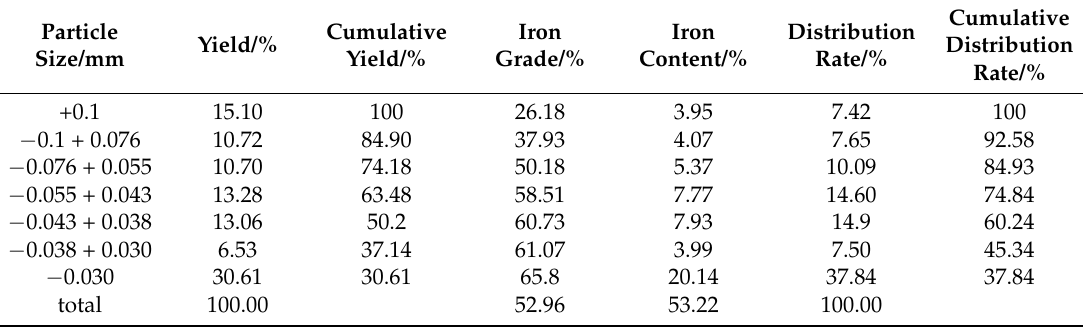
Table 2. The properties of